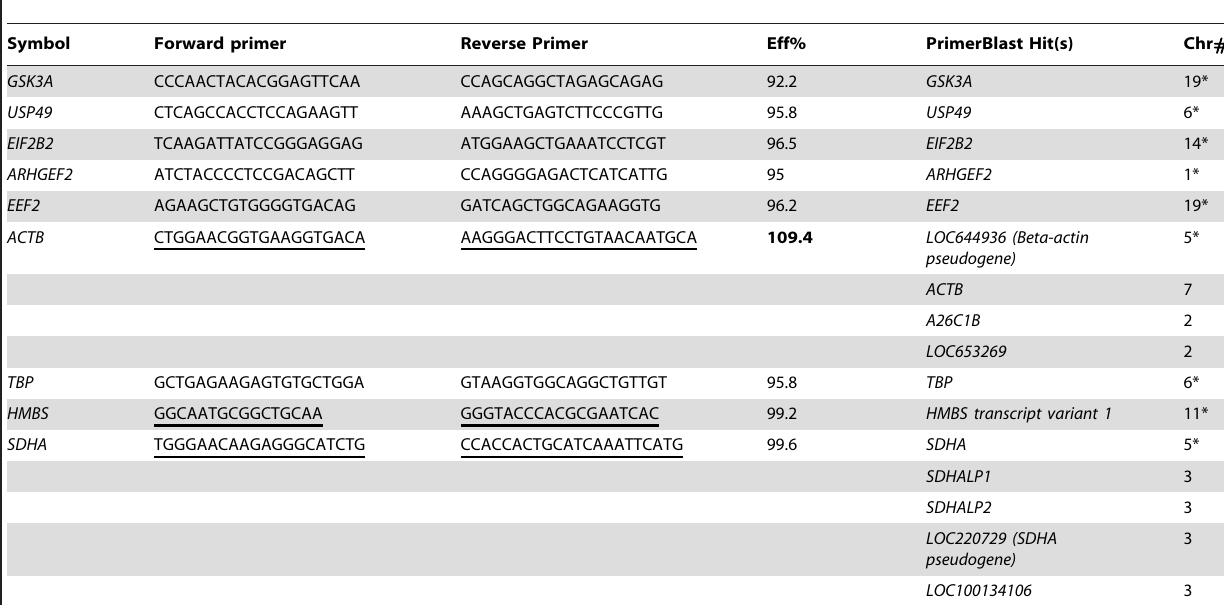
Table 2. Primer sequences for candidate control genes, efficiency, and primerBlast results.